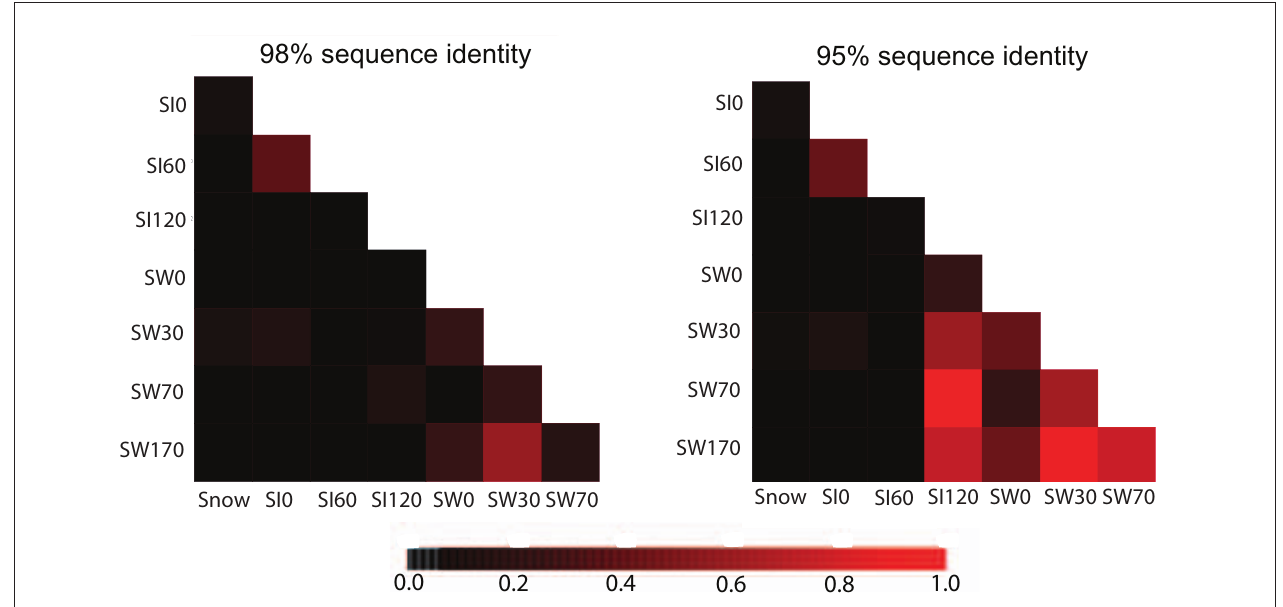
Figure 3 | Heatmaps comparing the diversity of eukaryotes among samples using the shared OTus defined at clustering identity of 98% (left) or 95% (right). Scale bar: Theta coefficient as measure of similarity between the structures of two communities, ranging from 0 (black) to 1 YC